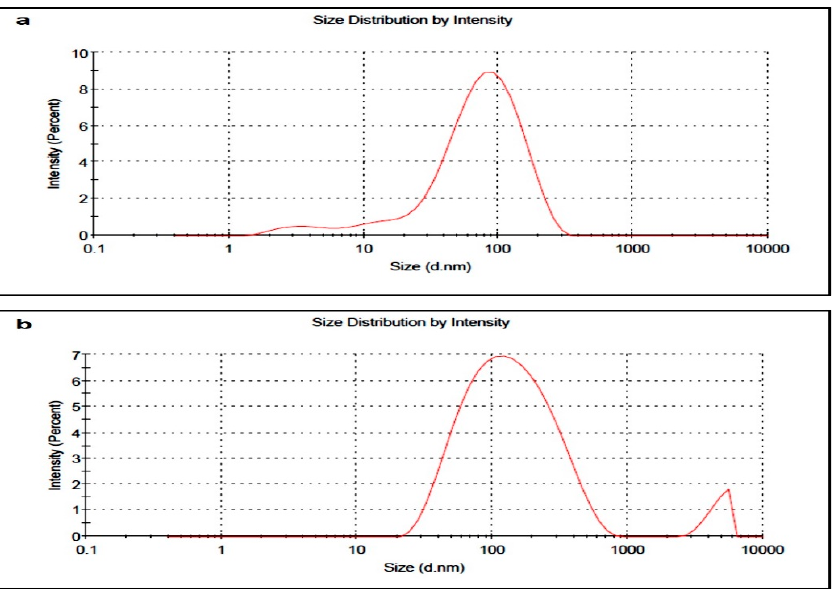
Figure 3. Z-average particle size of ( a ) GNPs and ( b ) CGNPs measured by DLS.